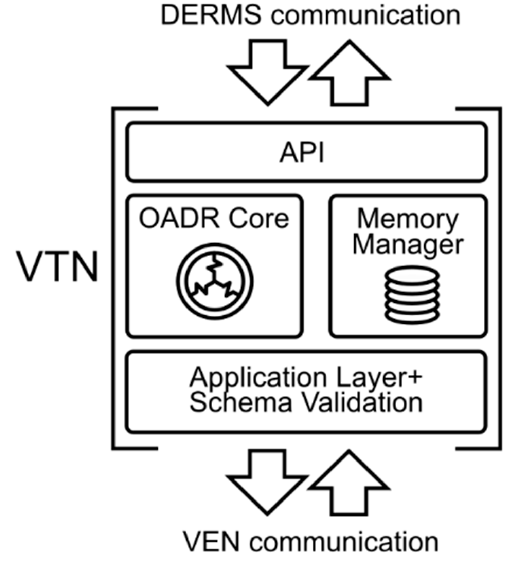
Figure 4. Architecture of the developed VTN with the different layers.